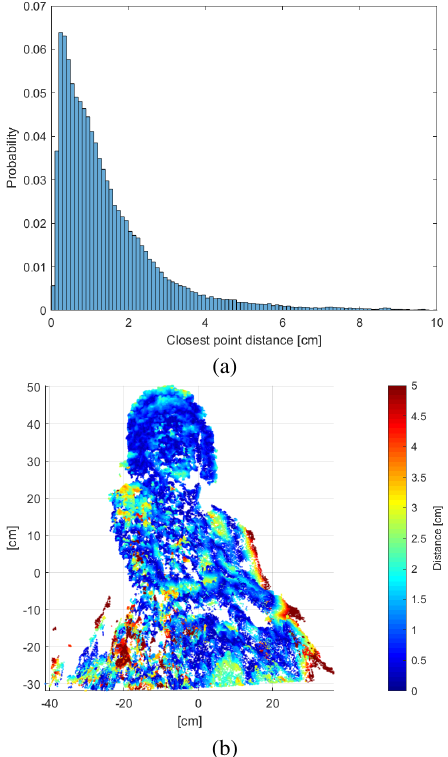
Figure 8. Comparison between smartphone stereo-vision 3D model and the reference one for the artwork shown in Fig. 4. (a) Point to point distance distribution. (b) Distance mapped on the 3D